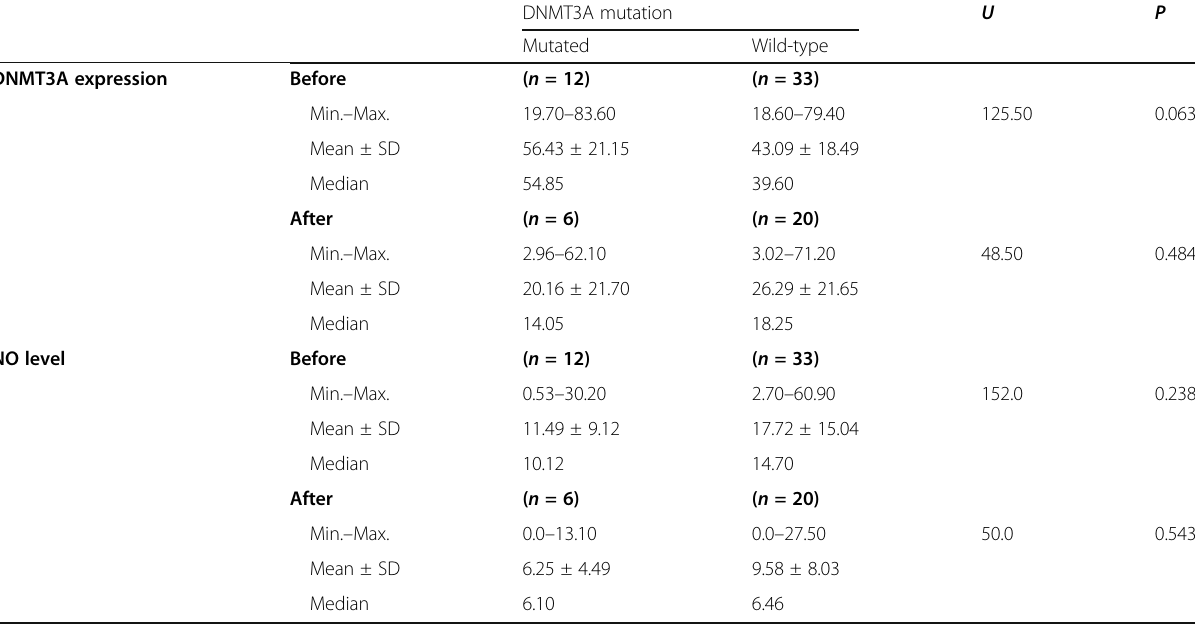
Table 6 Comparison of DNMT3A expression and NO level before and after treatment in relation to DNMT3A mutational status DNMT3A mutation U P Mutated Wild-type